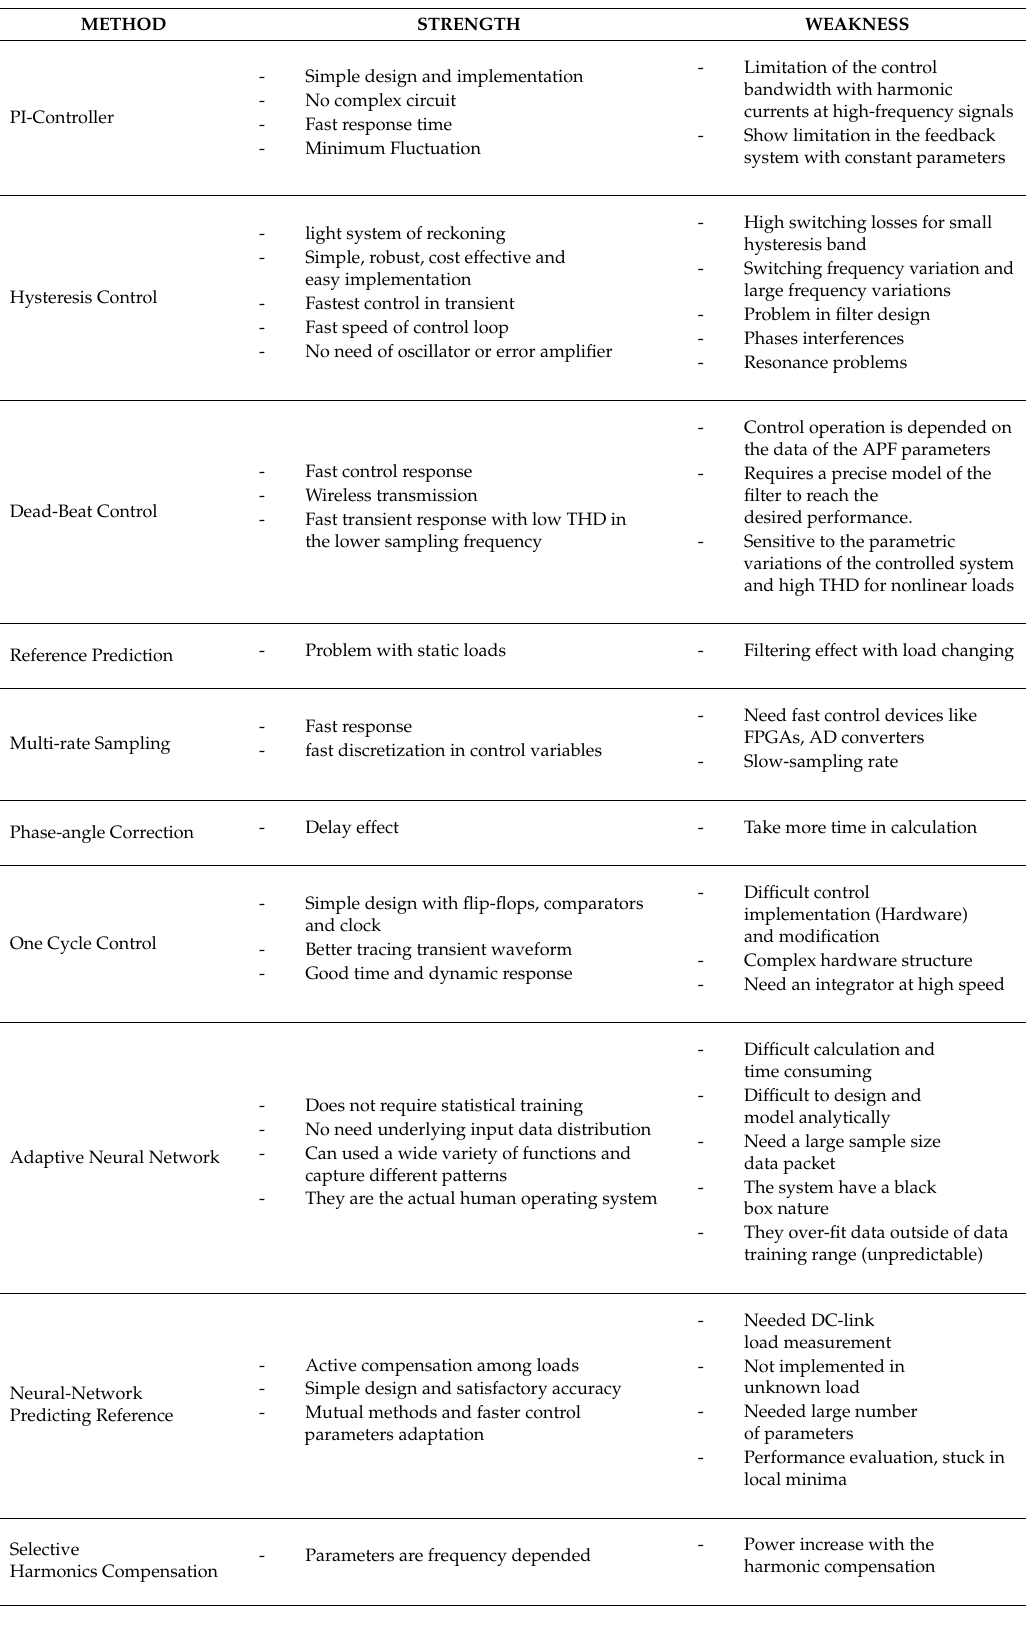
Table 11. Strengths and weaknesses of APF/STATCOM control